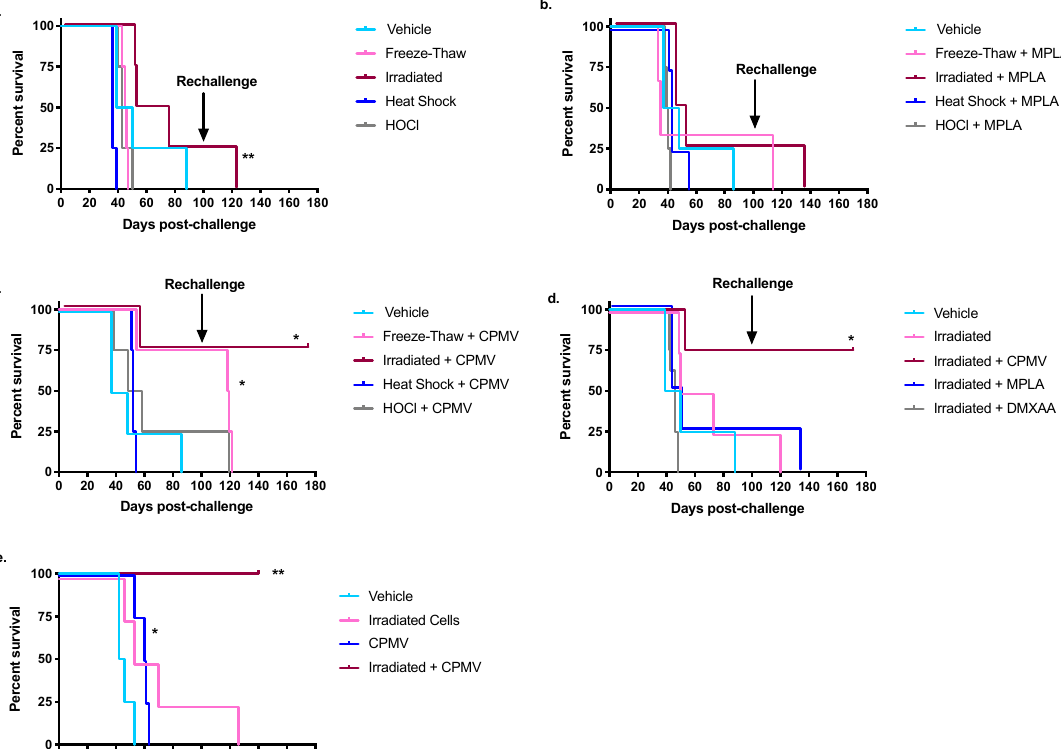
Figure 1. The combination of cowpea mosaic virus nanoparticles (CPMV) and irradiated cells significantly extends survival in a mouse model of ovarian cancer. ID8/VEGFA/defb29 cells were inactivated for intraperitoneal (IP) vaccine injection in one of four different ways: irradiation, freeze–thaw, heat shock, or HOCl oxidation (see methods for cell preparation). Following two vaccinations seven days apart, mice were challenged with live tumor cells and survival tracked. ( a ) Irradiated p = 0.007 compared to freeze–thaw, n = 4 in all groups; ( b ) cells co-delivered IP with 100 µg MPLA. Irradiated p = 0.35 compared to freeze–thaw and p = 0.59 compared to vehicle, n = 4 in all groups except freeze–thaw + MPLA where n = 3; ( c ) inactivated cells were co-delivered IP with 100 µg CPMV, n = 4 in all groups, freeze–thaw p = 0.03, irradiated p = 0.03 compared to vehicle; ( d ) mice received irradiated ID8/VEGFA/defb29 cells co-delivered IP with PBS, 100 µg CPMV, 100 µg MPLA, or 250 µg DMXAA. n = 4 in all groups except irradiated + DMXAA where n = 8. Irradiated + CPMV p = 0.03 or less when compared to any other group; ( e ) n = 4 in all groups. Irradiated + CPMV p = 0.007 or less compared to any other group. ( a – e ) When twice the average length of the survival of vehicle-treated mice had passed, surviving mice were rechallenged with 5 × 10 6 cells, as denoted by the arrows. p values compare survival curves with a log-rank (Mantel–Cox) test. All p values are compared to vehicle-treated controls unless otherwise noted ** 0.001 < p < 0.01; * 0.01 < p < 0.05.